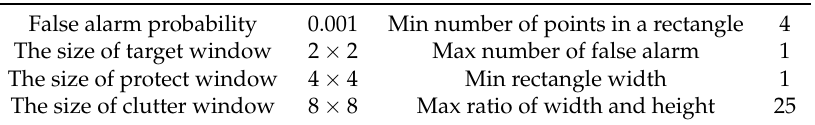
Table 5. Parameter settings of Experiment III.